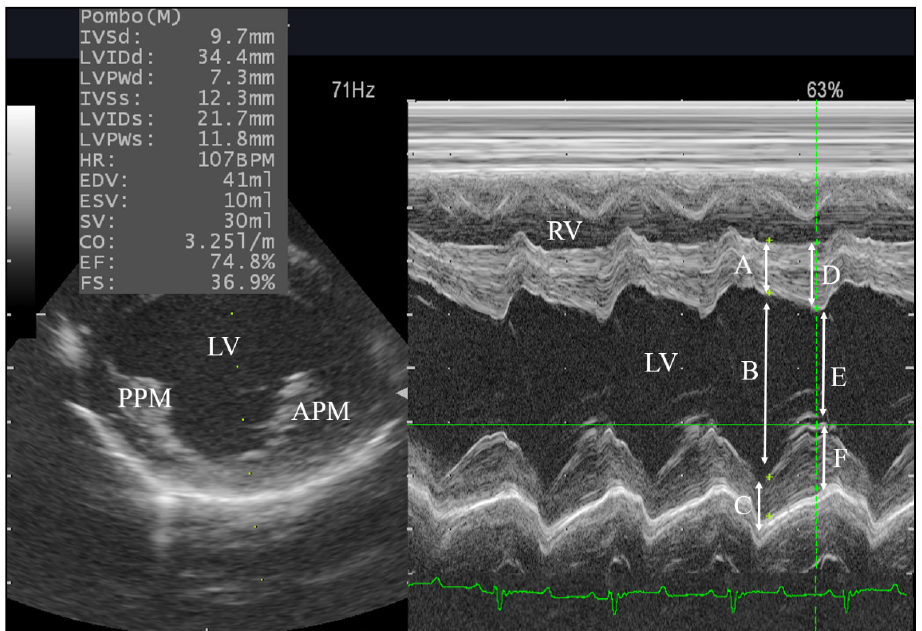
Figure 1. Evaluation of the left ventricle (LV) dimensions in male goats from right parasternal short-axis view (RPSAV) at the papillary muscles level using M-mode echocardiography in lateral recumbency. PPM, posterior papillary muscle; APM, anterior papillary muscle; RV, right ventricle; A, interventricular septum in diastole (IVSd); B, left ventricular internal diastolic diameter (LVIDd); C, left ventricular free wall diastolic diameter (LVFWd); D, interventricular septum in systole (IVSs); E, left ventricular internal systolic diameter (LVISd); F, left ventricular free wall systolic diameter (LVFWs).